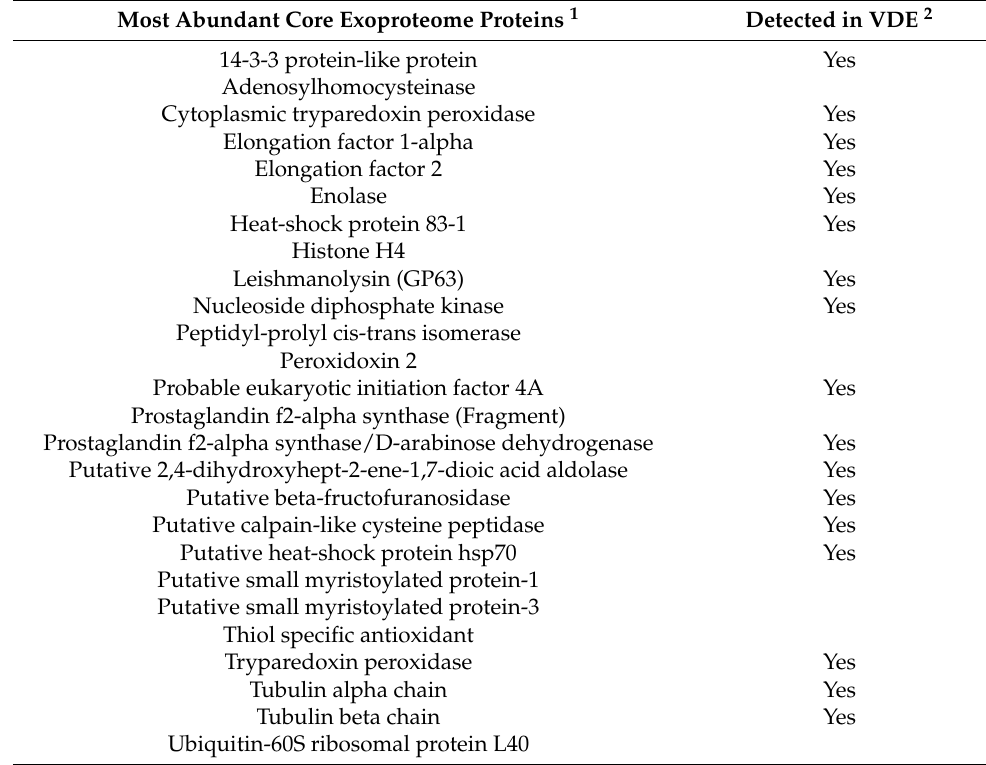
Table 2. Presence of VDE proteins identified in the most abundant core exoproteome proteins that were detected in promastigotes from 7 different Leishmania spp. ( L. infantum, L. major, L.